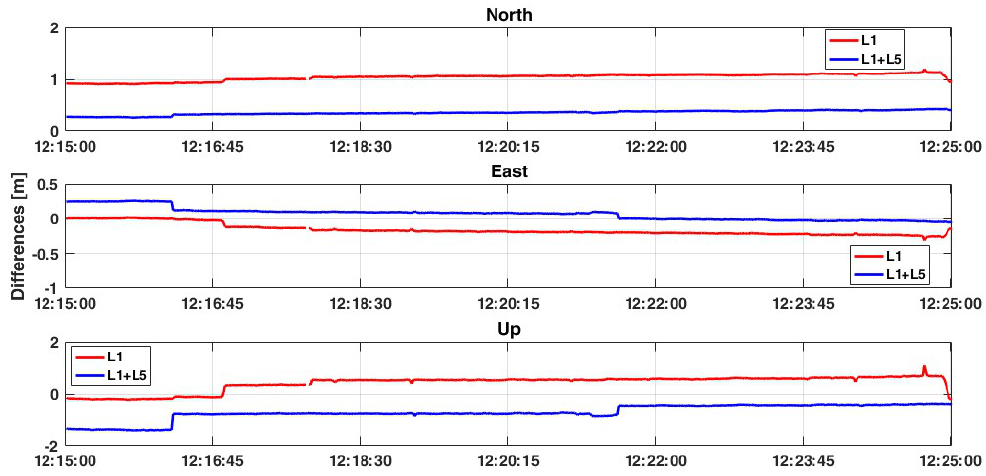
Figure 10. Comparison between L1 and L1+L5 solutions considering GPS+GLONASS+Galileo constellations with a ratio =30. Table 10. Positioning results considering the GPS+ Galileo constellations.